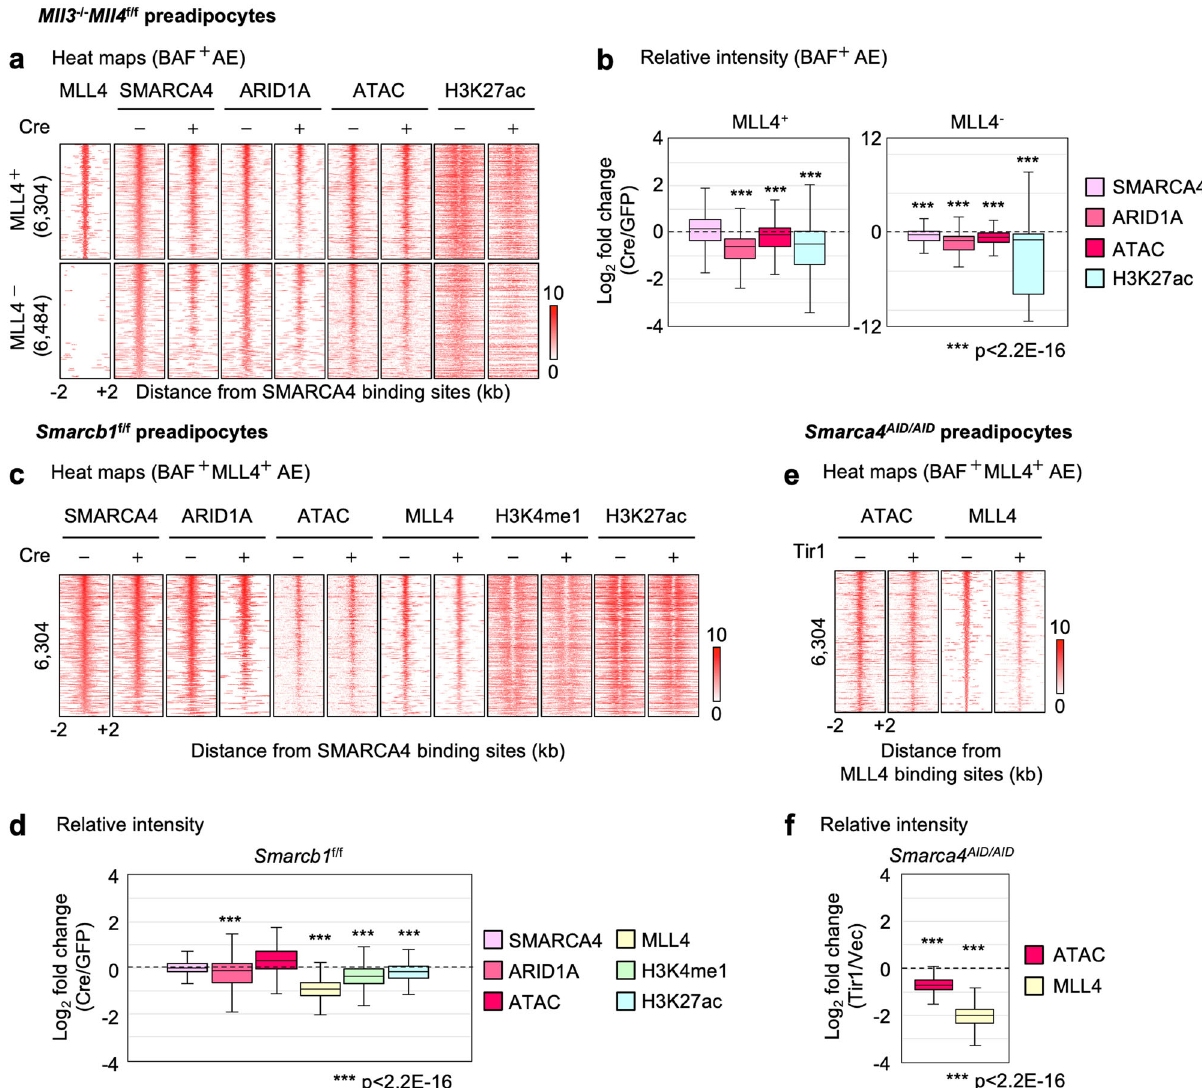
adipogenesis in fi broblasts 24 . Knockdown of Smarcb1 in 3T3-L1 white preadipocytes inhibits adipogenesis 31 . Using the AID